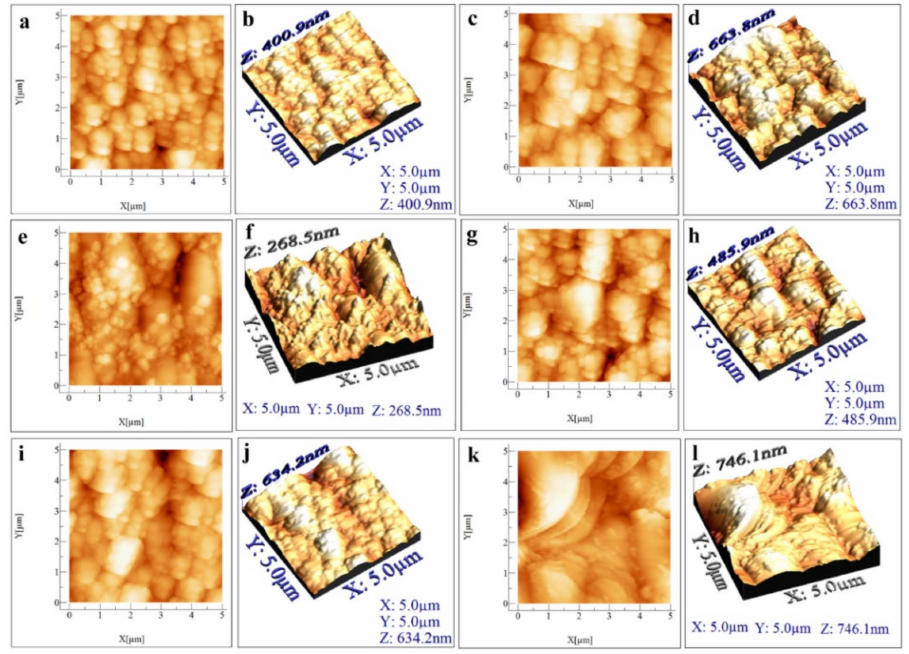
Figure 6. 5 µ m × 5 µ m 2D AFM micrographs obtained for the HA7 ( a ), HA8 ( c ), HA9 ( e ), HA10 ( g ), HA11 ( i ), and HA12 ( k ) samples and their respective 3D representations ( b , d , f , h , j , l